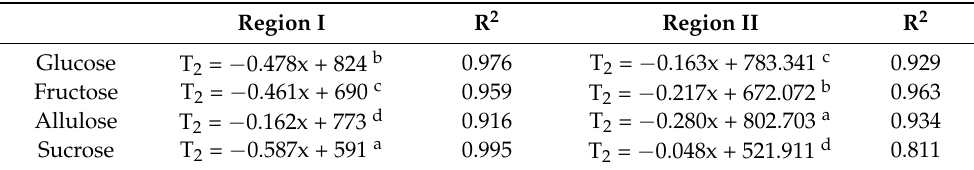
Table 2. Model fitting of T 2 (ms) with respect to time for regions I and II.